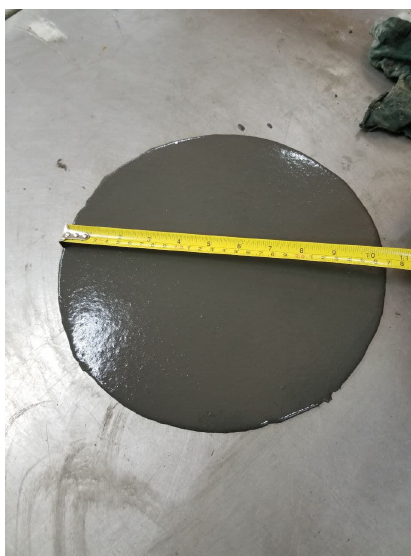
Figure 4: Flow test of